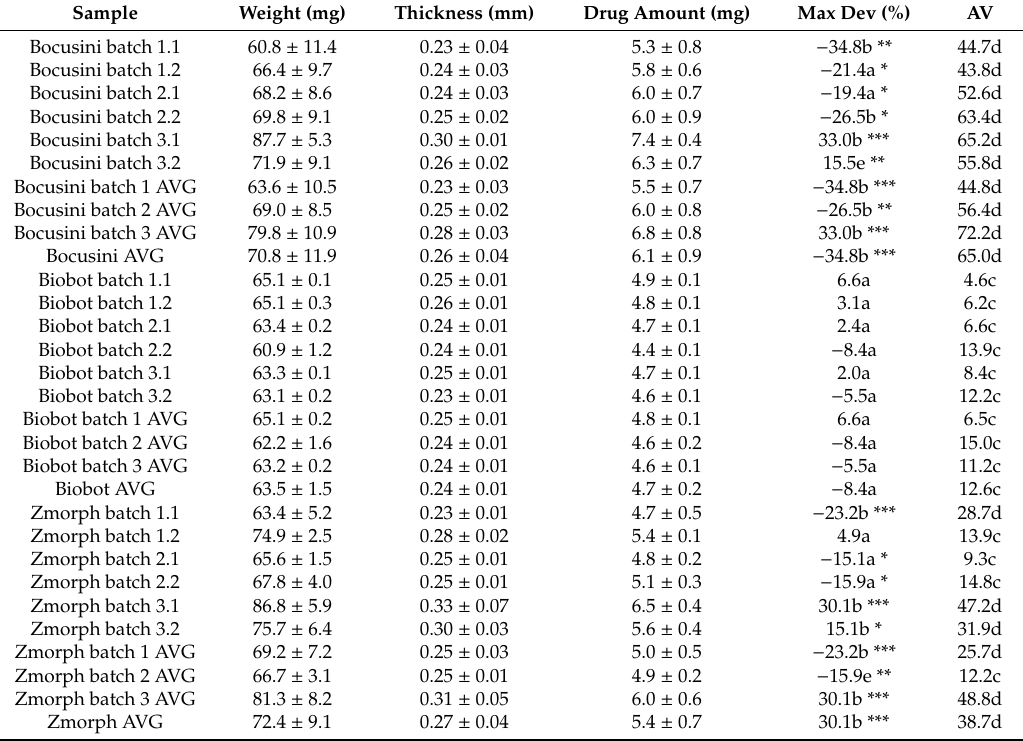
Table 3. Weight, thickness, drug amount, the maximum deviation (Max Dev) of content uniformity, and uniformity of dosage units (acceptance value (AV)) of all the printed batches. Six doses were printed and measured for each half batch, and the average (AVG) and standard deviations were calculated for each half batch, batch, and all batches together for each printer.